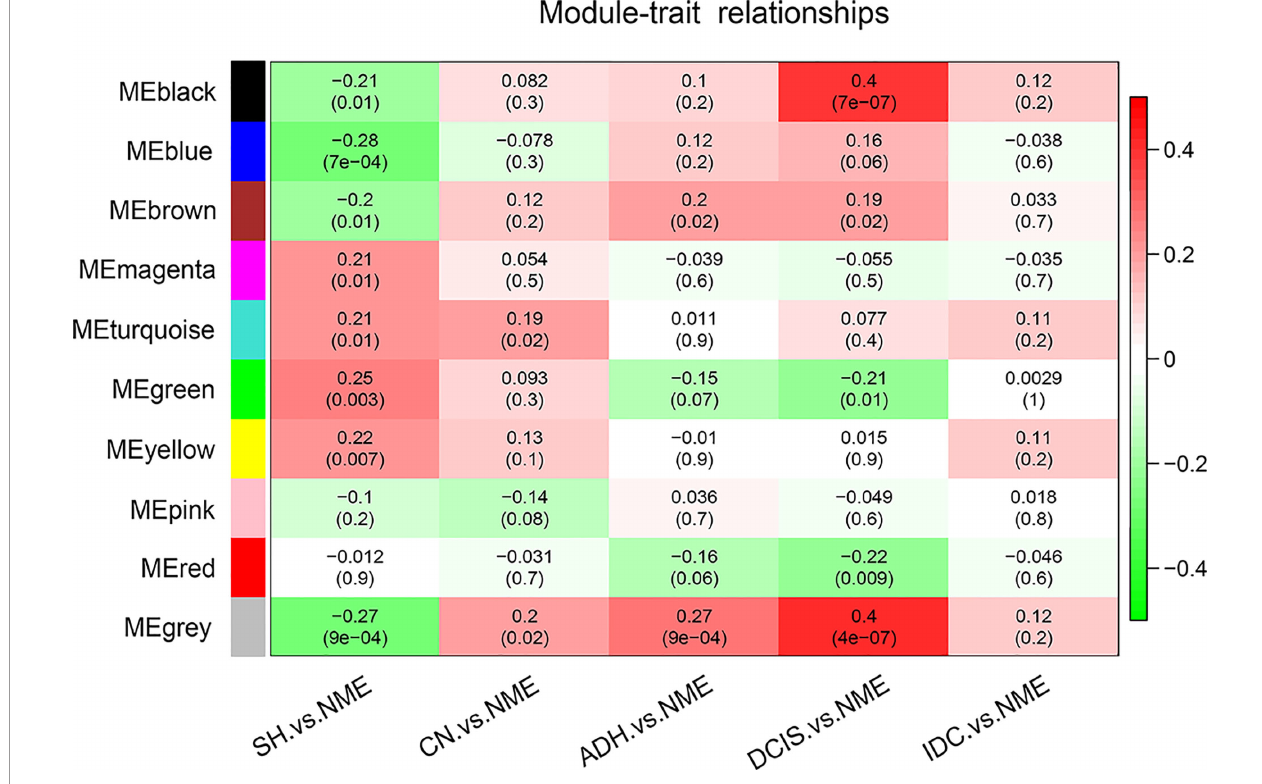
FIGURE 2 | Pearson ’ s correlation coef fi cients between MEs and clinicopathological variables. Relationships of the GS measure for weight with breast disease- related genetic and network-based variables of the ten colored modules. NME, normal mammary epithelium; SH, simple ductal hyperplasia; CN, cancer normal; ADH, atypical ductal hyperplasia; DCIS, ductal carcinoma in situ; IDC, invasive ductal carcinoma; ME, module